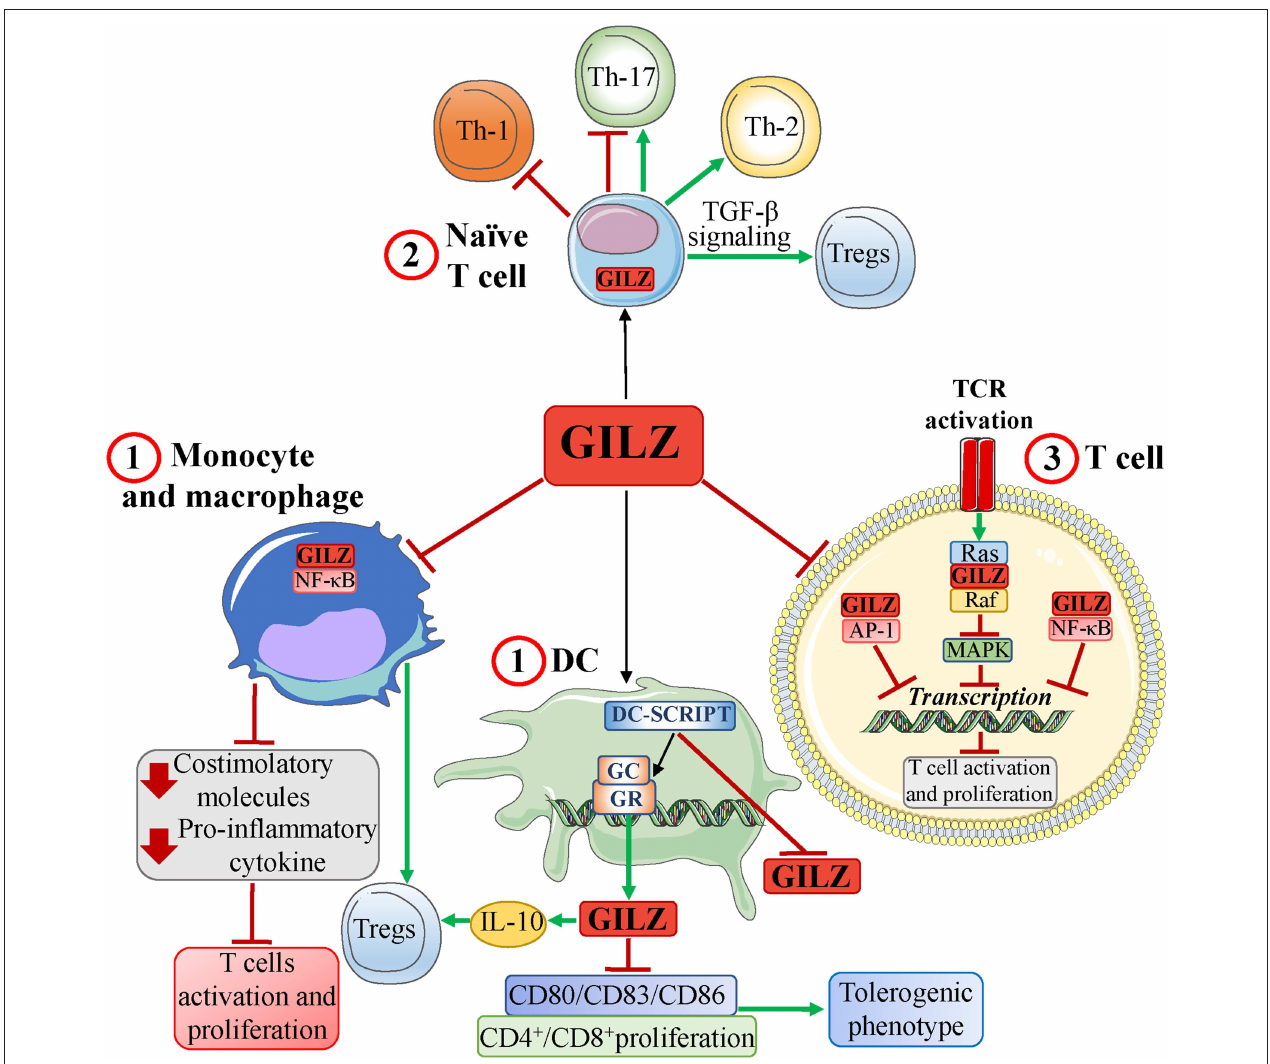
FIGURE 2 | GILZ and the T-cell response. GILZ, expressed basally and/or in response to GCs, induces: (1) a tolerogenic dendritic cell (DC) phenotype and inhibition of human monocyte and mouse macrophage activation via inhibition of NF- κ B, thereby limiting production of both proinflammatory chemokines, and costimulatory molecules. In DCs, GILZ expression is regulated by a GR corepressor, DC-specific transcript (DC-SCRIPT), whose recruitment inhibits GILZ expression. GILZ-induced inhibition of APC functions promotes development of Tregs and ultimately inhibits T-cell activation; (2) a modulation of naïve T-cell differentiation (expressing endogenous GILZ) that includes induction of Th-2 cells and Tregs (favoring TGF- β signaling), inhibition of Th-1 cells, and inhibition or development of Th-17 cells; (3) an inhibition of TCR signaling by inhibiting pathways, such as MAPK, and transcription factors, such as AP-1, and NF- κ B, through protein-protein interactions. Red T-headed leaders indicate inhibition; green arrow-headed leaders indicate